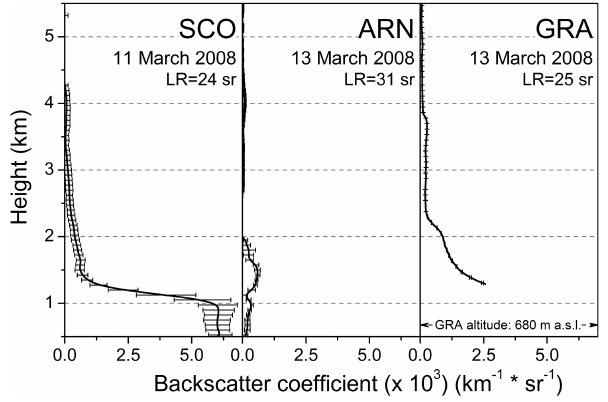
Fig. 6. Height-resolved backscatter coefficients at 12:00UTC (1- h averaged profiles) for non-dusty conditions over SCO site (left), and ARN (centre) and GRA (right) stations (GRA station altitude: 680m a.s.l.). Both lidar-retrieved LR and date of measurements are indicated in each